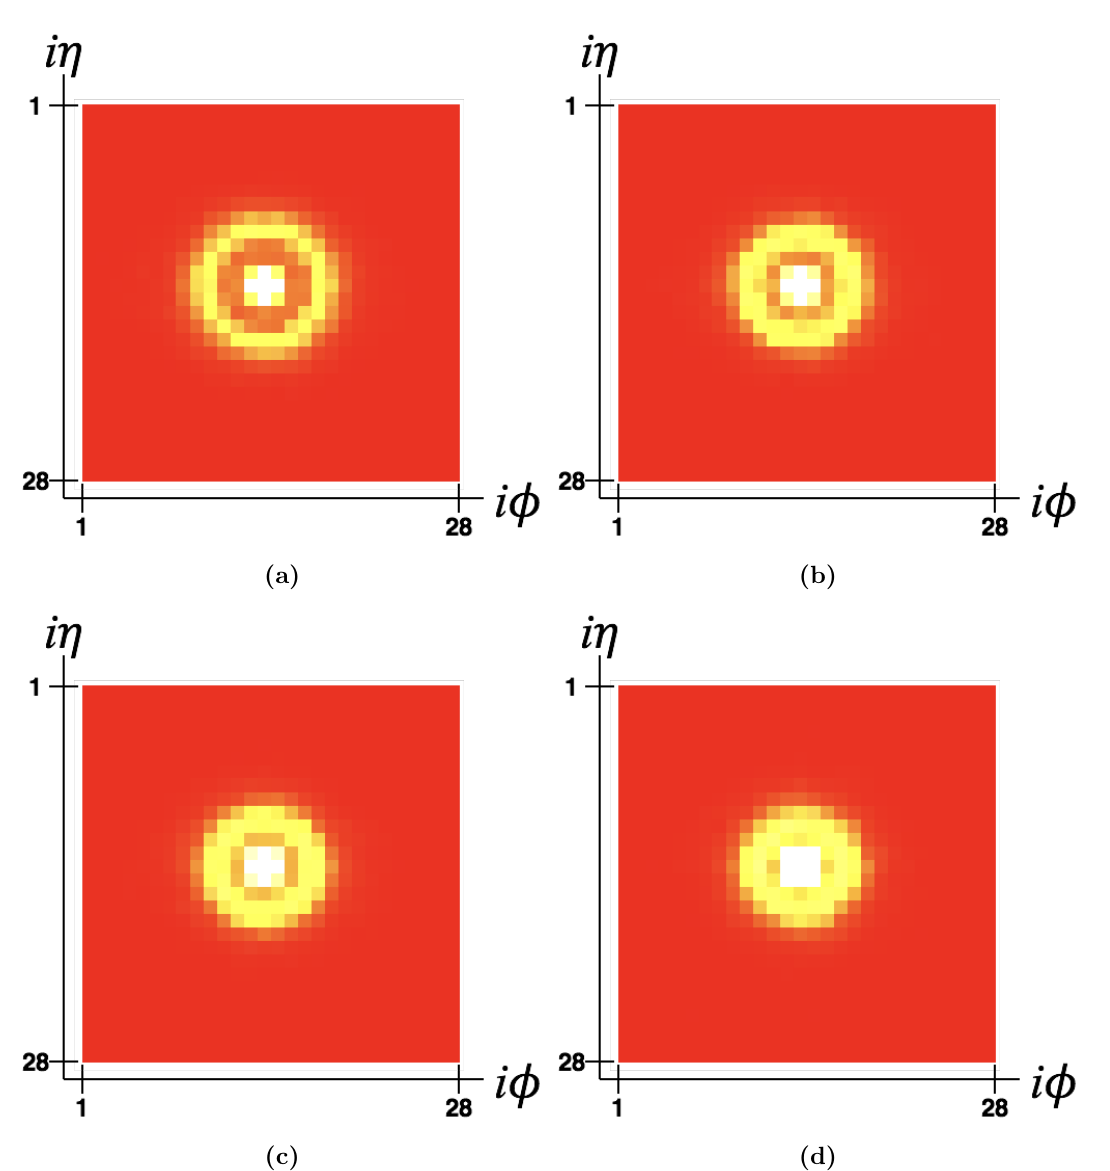
Figure 4. Average of 50,000 images for (a) Z boson with no displacement; (b), (c), (d) Z boson displaced within transverse distance of 30 (cid:0) 50 cm, 50 (cid:0) 70 cm and 70 (cid:0) 90 cm from PV respectively. These are 28 (cid:2) 28 images in the i(cid:17) (cid:0) i(cid:30) plane with the highest energy bin in the center (14,14). With increasing displacement, the distance between two jets decreases, as seen from the (cid:12)gures.